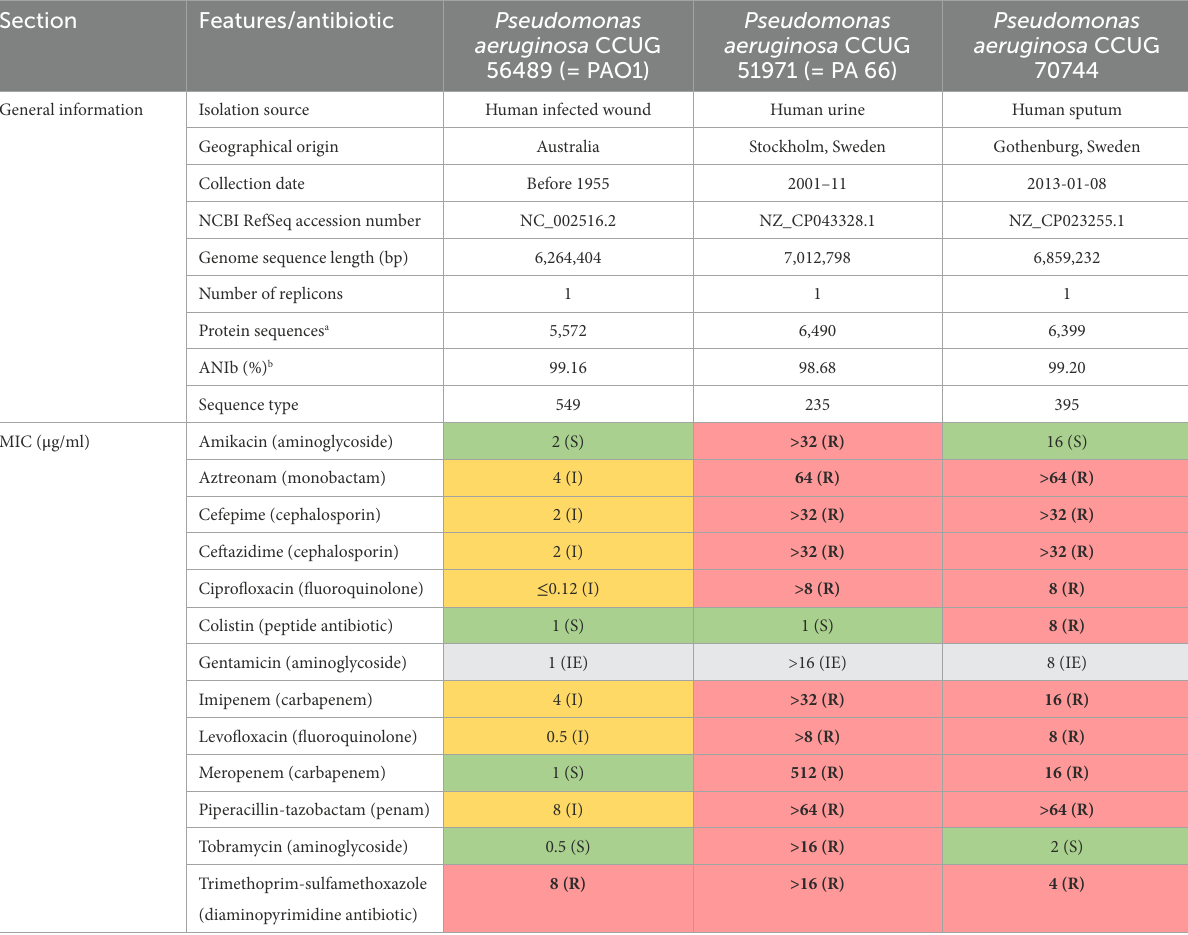
TABLE 1 General characteristics of the strains and minimal inhibitory concentrations (MICs) of the antimicrobial agents included in the “ Pseudomonas / Acinetobacter standard panel” of the National Reference Laboratory for Antibiotic Resistance (Växjö, Sweden).